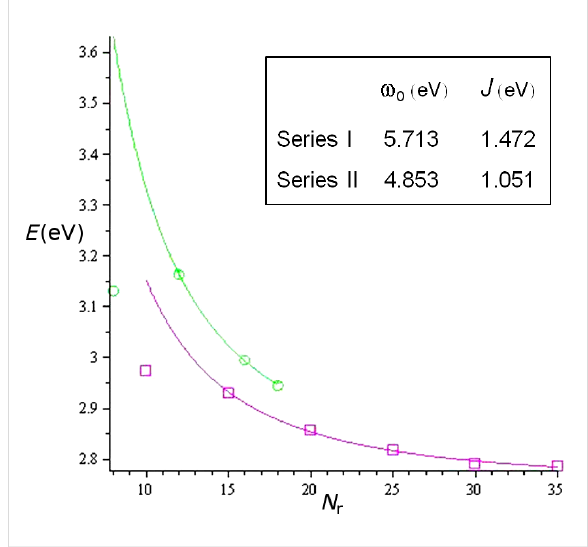
Figure 5: Diagram of the energy of the absorption band (eV) versus the number of thiophenes in the macrocycles of series I (circles) and II (squares), including the least-squares fit to Equation